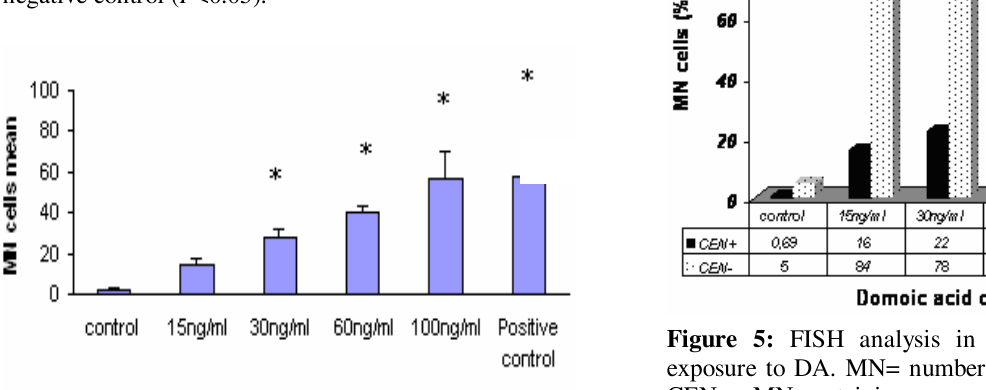
Figure 2: MN frequency in Caco-2 cells exposed to OA. Data are expressed as mean ± SD. *indicates significant differences as compared to negative control ( P <0.05).